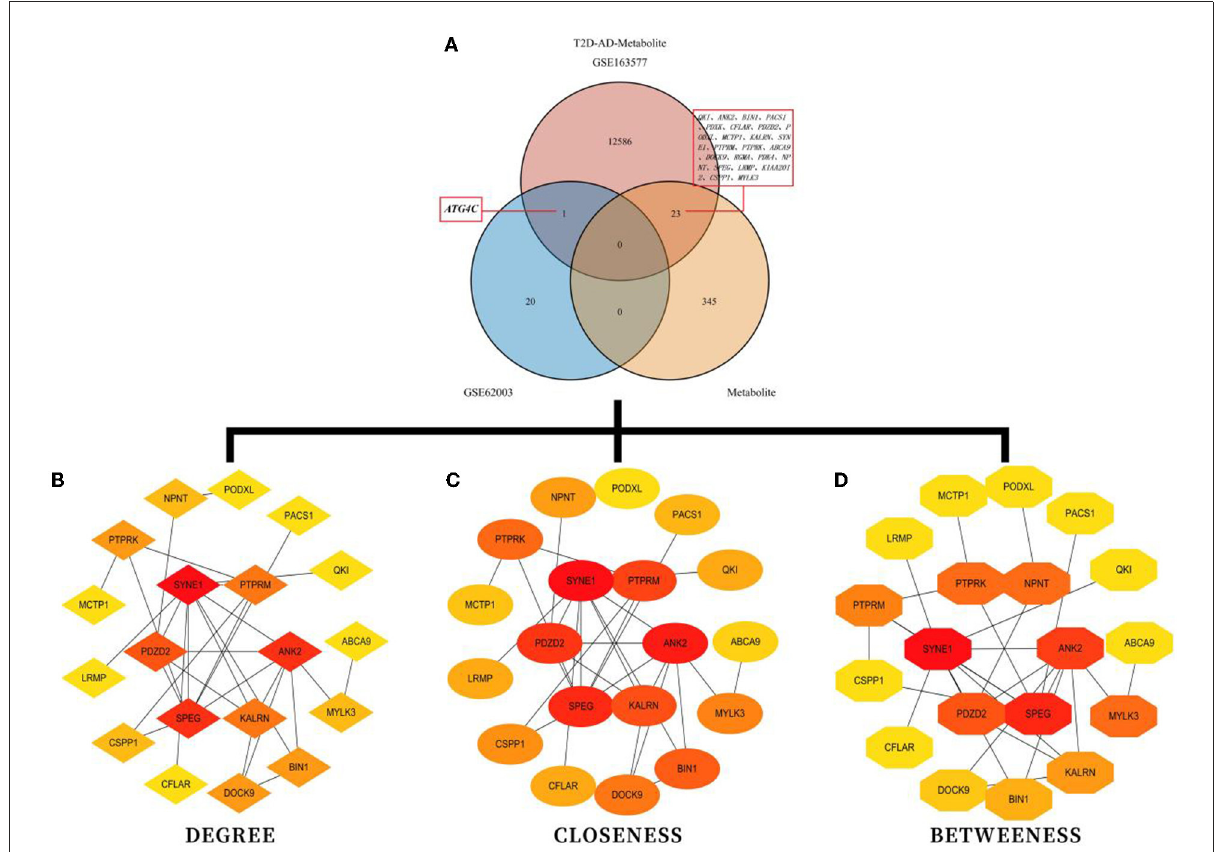
FIGURE4 Enrichment analysis for the identification of markers genes. (A) Venn diagram demonstrating high-fiber-diet–T2DM–AD-related marker genes. (B) Potential core target genes identified based on degree values. (C) Potential core target genes identified based on closeness values. (D) Potential core target genes identified based on between-ness